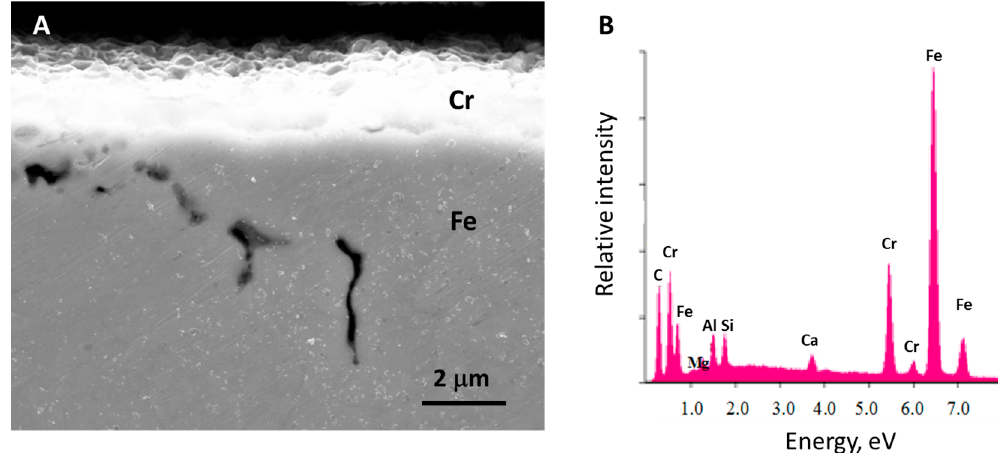
Figure 4. X-Section for Thickness Analysis. ( A ) Image of embedded and polished sample prepared from chrome oxide particle precursor with a weight ratio of urea: chrome (III) 2:1, coated by dipping and dried three times, before heat treatment. The surface layer is approximately 3 microns thick.